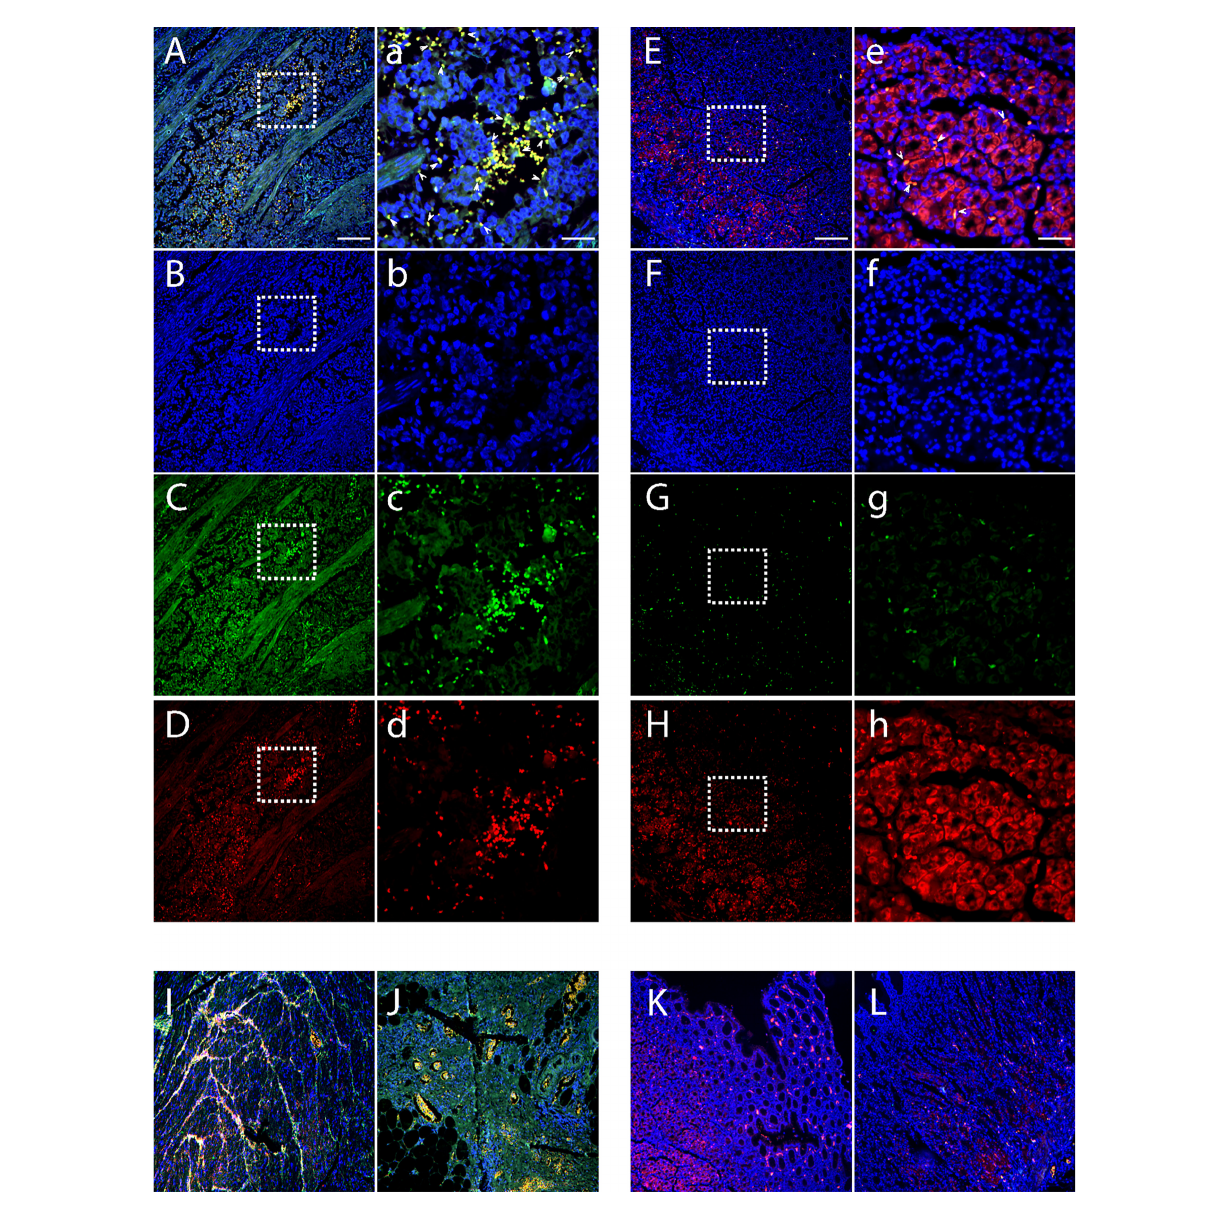
FIGURE 1 Location of CRC-in fi ltrated myeloid cells and Bv8 in tumor tissue and NAT of 3 patients with CRC. (A – D) Tumor tissue of a CRC patient. Sample was labelled with DAPI (blue), MPO (red) and anti-Bv8 (green) through immuno fl uorescent staining. MPO was used as myeloid cell marker. Arrowheads in insets depict co-localization of Bv8 and in fi ltrated myeloid cells. (E – H) NAT of the same CRC patient were labelled with DAPI (blue), MPO (red) and anti- Bv8 (green) through immuno fl uorescent staining. MPO was used as myeloid cell marker. Arrowheads in insets depict co-localization of Bv8 and in fi ltrated myeloid cells. (I – L) The expression and location of myeloid cells and Bv8 in another two CRC patients. Small letters a-h indicate the zoom-in image of the squared area from A-H respecively. Scale bar: 200 µm (A – L) , 50 m m (A – H)